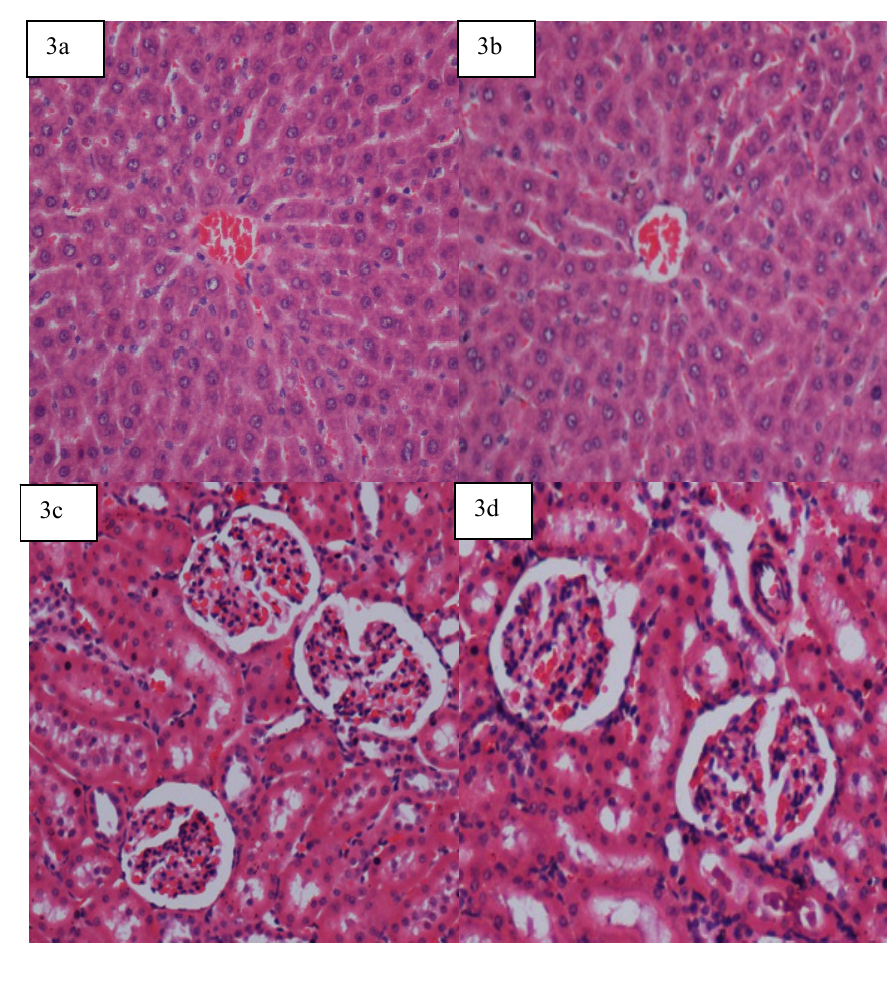
Figure 3. Histology and pathology snapshots of ( 3a ) liver tissue in a rat pre-treated with vehicle (distilled water) showed normal appearance, ( 3b ) liver tissue in a rat pre-treated with 5 mg/kg adiponectin showed normal appearance ( 3c ) kidney tissue in a rat pre-treated with vehicle (distilled water) showed normal appearance ( 3d ) kidney tissue in a rat pre- treated with 5 mg/kg adiponectin showed normal structural